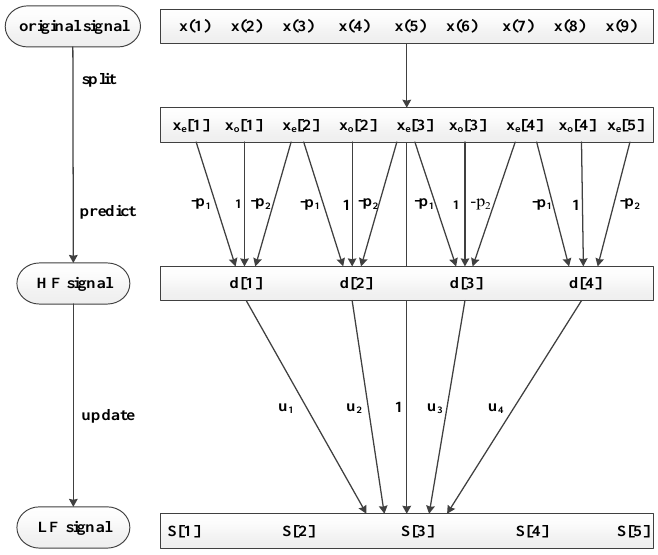
Figure 6. Rendering of lifting wavelet decomposition.